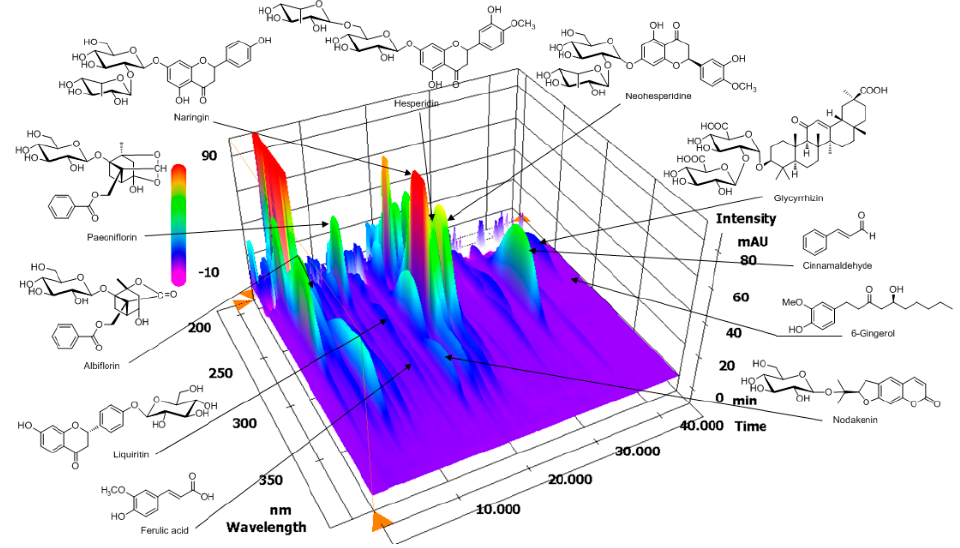
Figure 1. Three-dimensional chromatogram of OJS obtained using a high-performance liquid chromatography-photodiode array (HPLC-PDA).